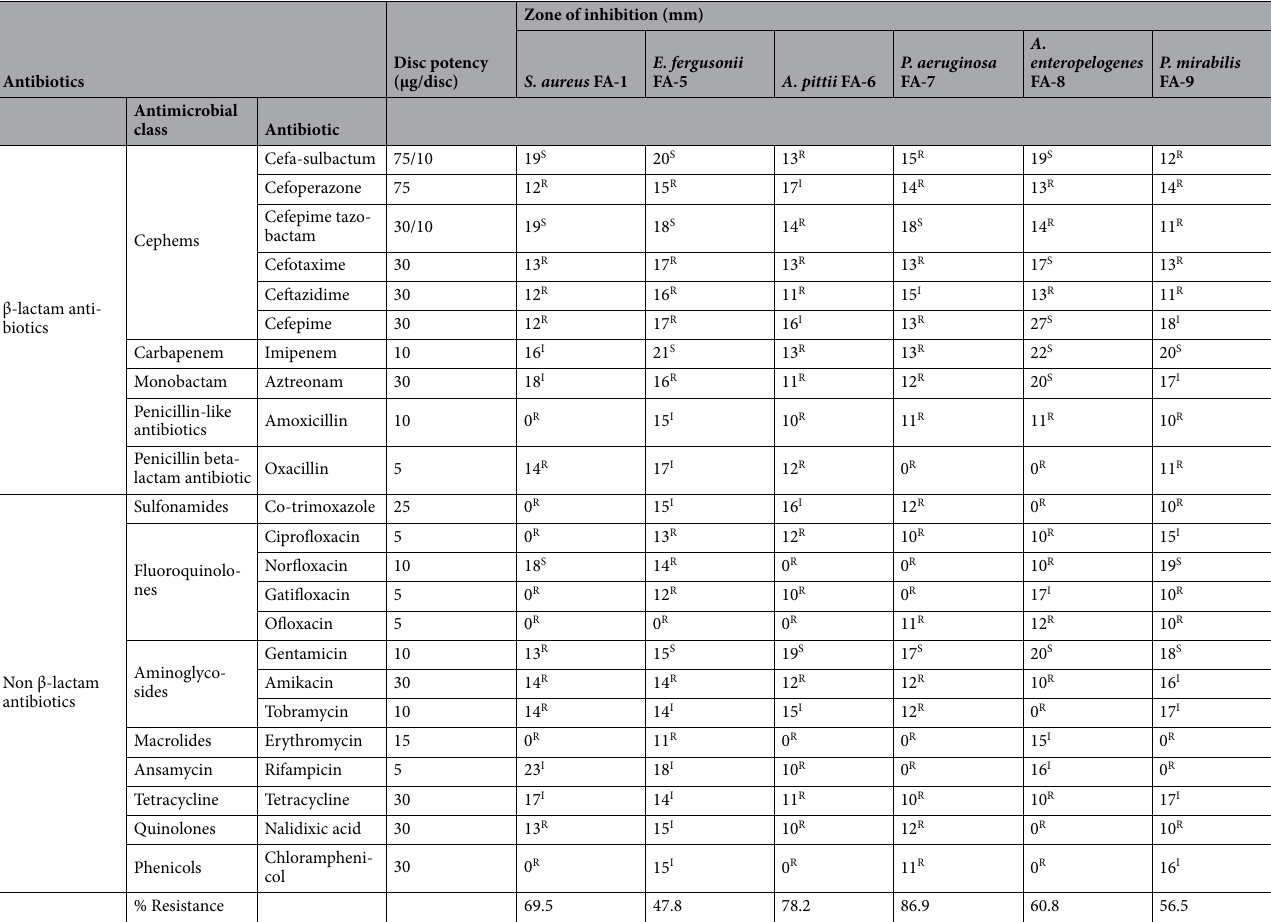
Table 3. Antibiotic resistance profile of bacterial isolates. S sensitive, I intermediate, R resistant based on Clinical and Laboratory Standards Institute (CLSI) and the European Committee for Antimicrobial